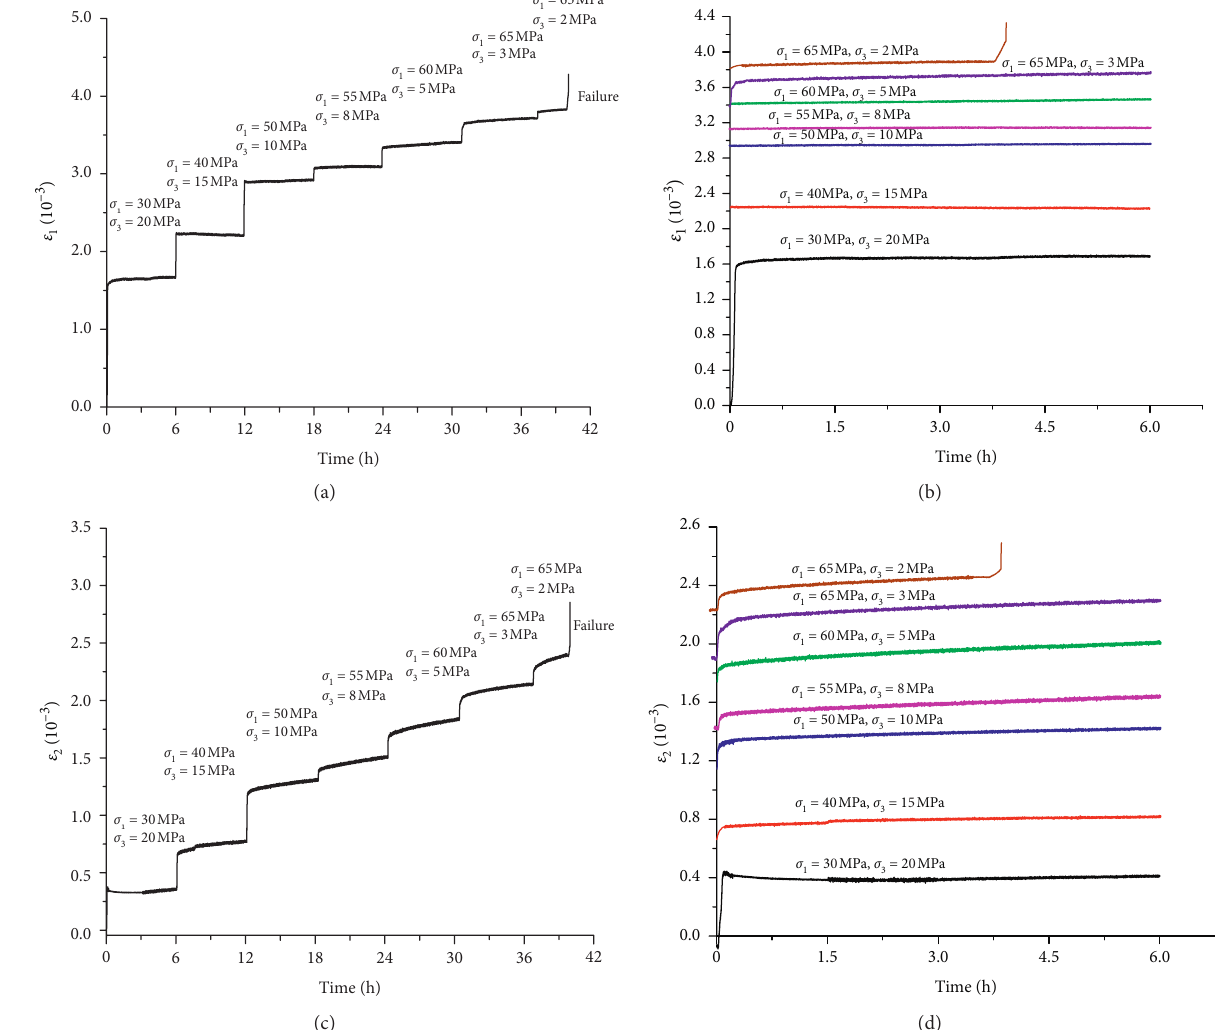
Figure 9: Unloading confining pressure with axial compression triaxial test results of mudstone. (a) Change of axial strain with time. (b) Isochronous curves of axial strain. (c) Change of lateral strain with time. (d) Isochronous curves of lateral